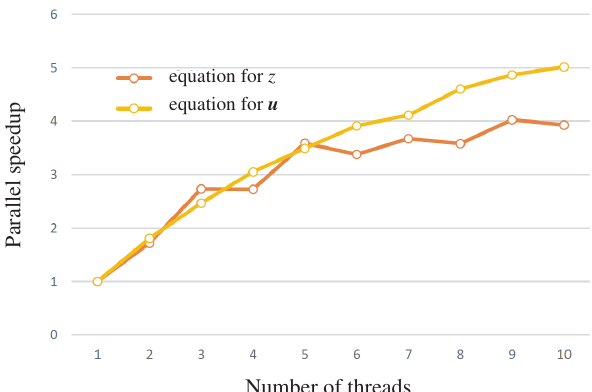
Figure 7. Parallel acceleration for the 201 × 201